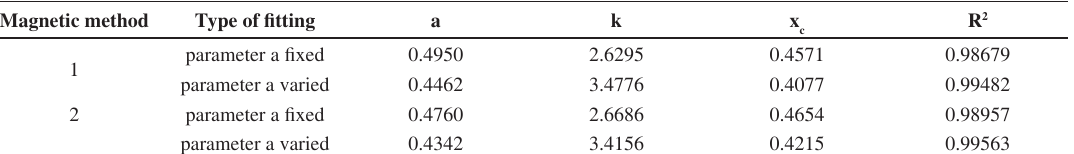
versus deformation with Equation 3. α ′